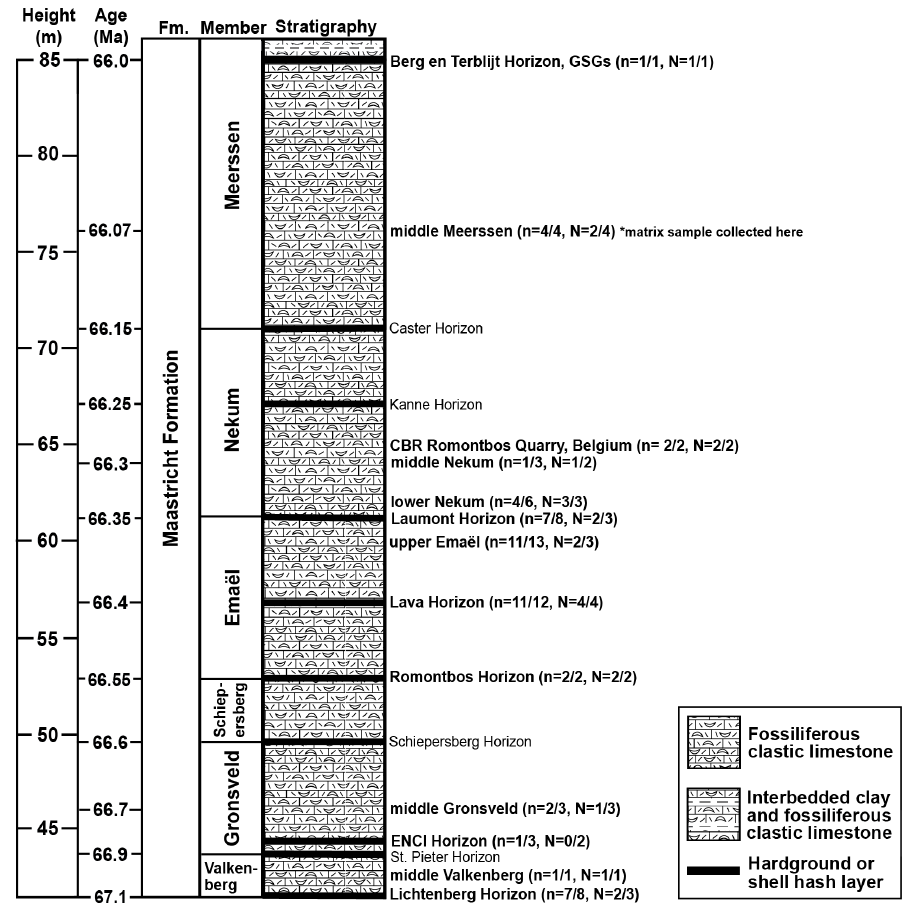
Figure 2. Composite stratigraphic section through the Maastricht Formation at ENCI quarry, Romontbos quarry, and Geulhemmerberg subterranean galleries. Samples collected in the Romontbos quarry and GSGs were placed on the ENCI quarry stratigraphic framework using the age model from Vellekoop et al. (2022; Table S2). From each collection horizon or zone, the number of specimens collected, the number that passed diagenesis screening, the number of well-preserved specimens successfully analyzed for clumped isotopes, and the total number of specimens attempted for clumped isotopes (including some poorly preserved specimens) are listed as follows ( n = passed/collected, N = good clumped/attempted). Out of 66 shells sample, 54 shells passed screening, 33 were attempted, and 27 well-preserved shells were successful for (cid:49) 47 , plus one sample of matrix material from the Meerssen